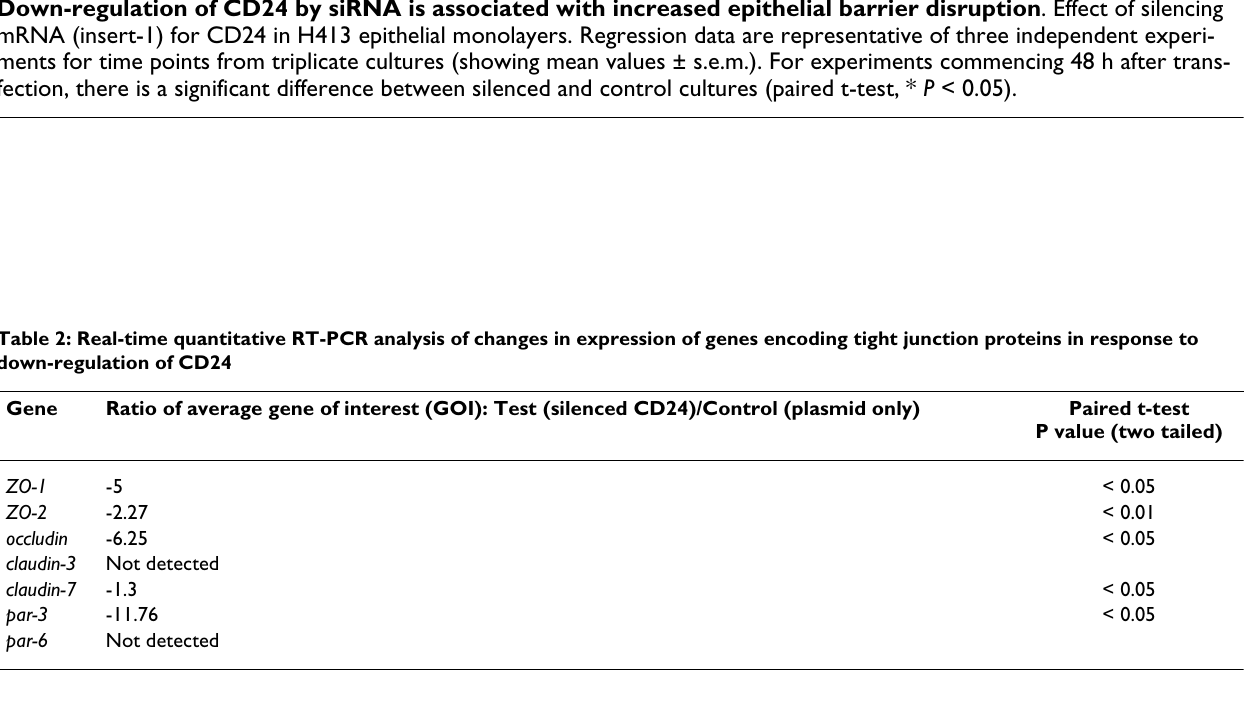
Figure 8 Down-regulation of CD24 by siRNA is associated with increased epithelial barrier disruption . Effect of silencing mRNA (insert-1) for CD24 in H413 epithelial monolayers. Regression data are representative of three independent experi- ments for time points from triplicate cultures (showing mean values ± s.e.m.). For experiments commencing 48 h after trans- fection, there is a significant difference between silenced and control cultures (paired t-test, * P < 0.05).